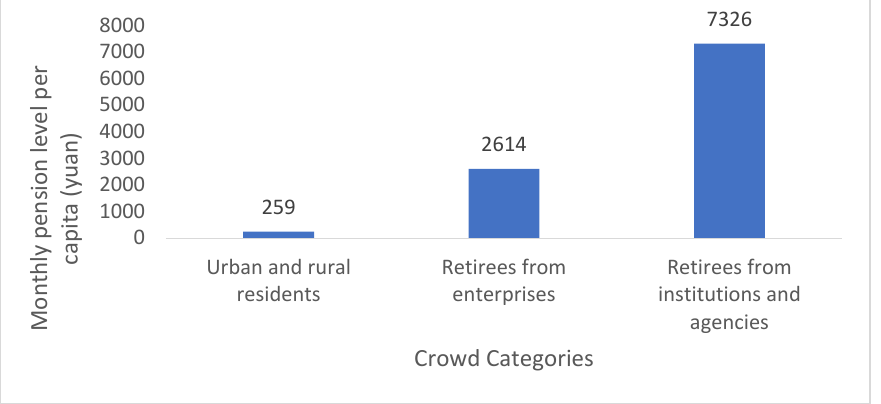
Figure 1. Per capita pension levels for different population groups in a city’s urban area, 2021. Source of data: Compiled from relevant notices and announcements of the Human Resources and